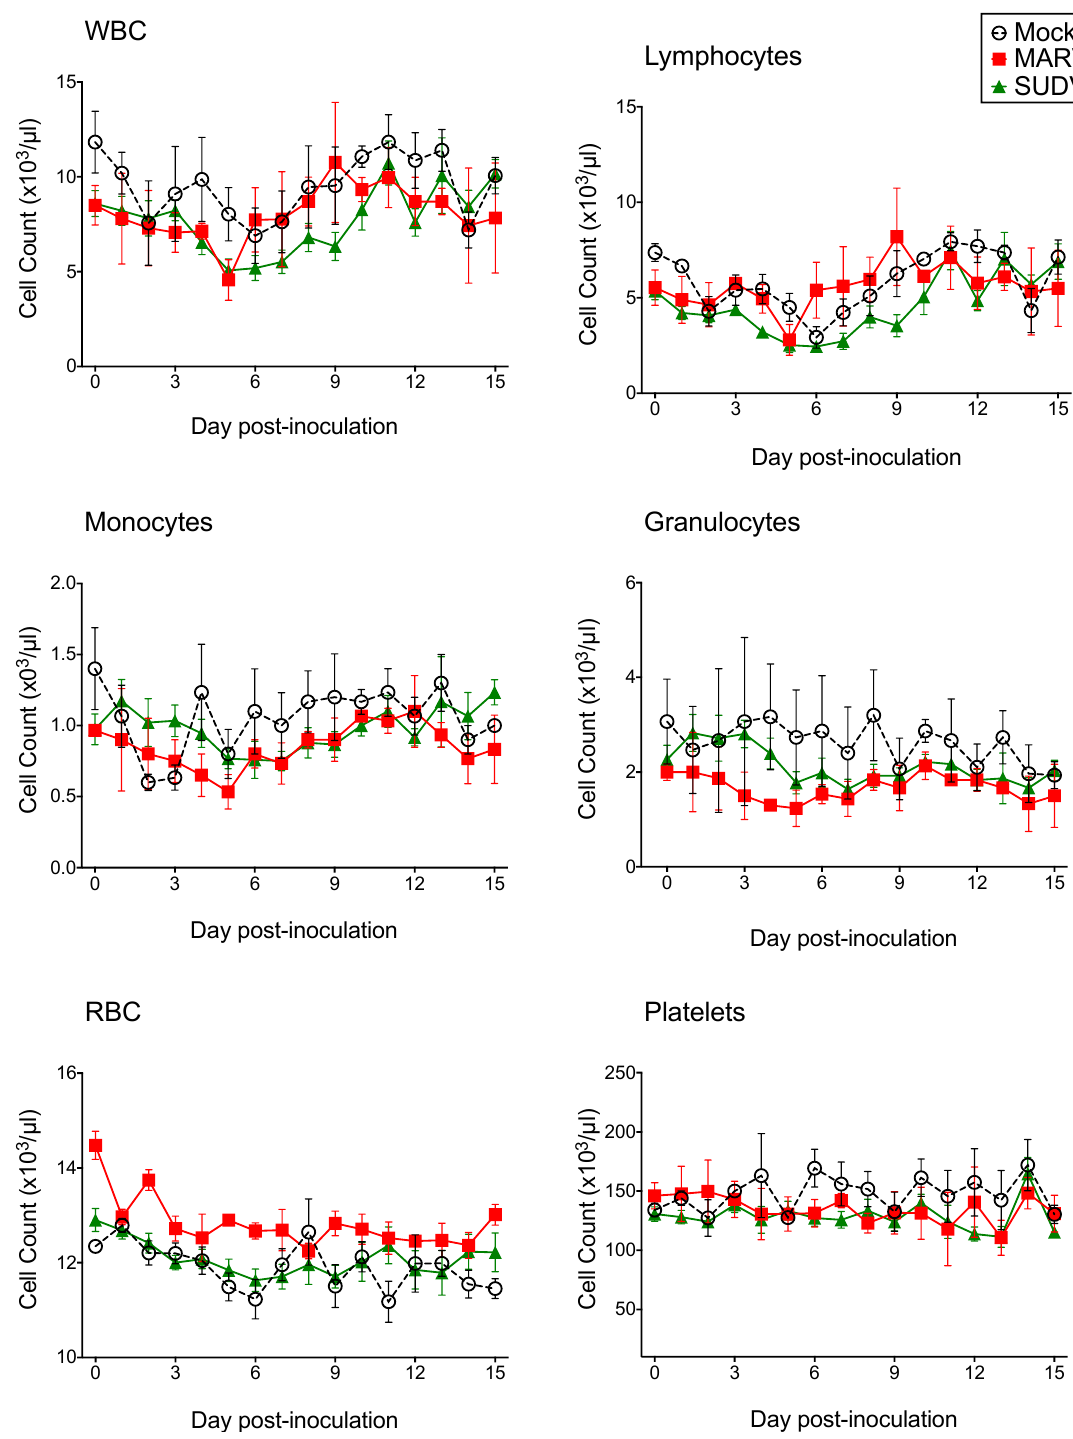
Figure 5. Complete blood count data for Egyptian rousette bats inoculated with Sudan virus ( n = 15, green triangles), Marburg virus ( n = 3, red squares) and mock-inoculated controls ( n = 3, open circles/dashed line) in a serial euthanasia study. WBC = white blood cell count, RBC = red blood cell count, MARV = Marburg virus, SUDV = Sudan